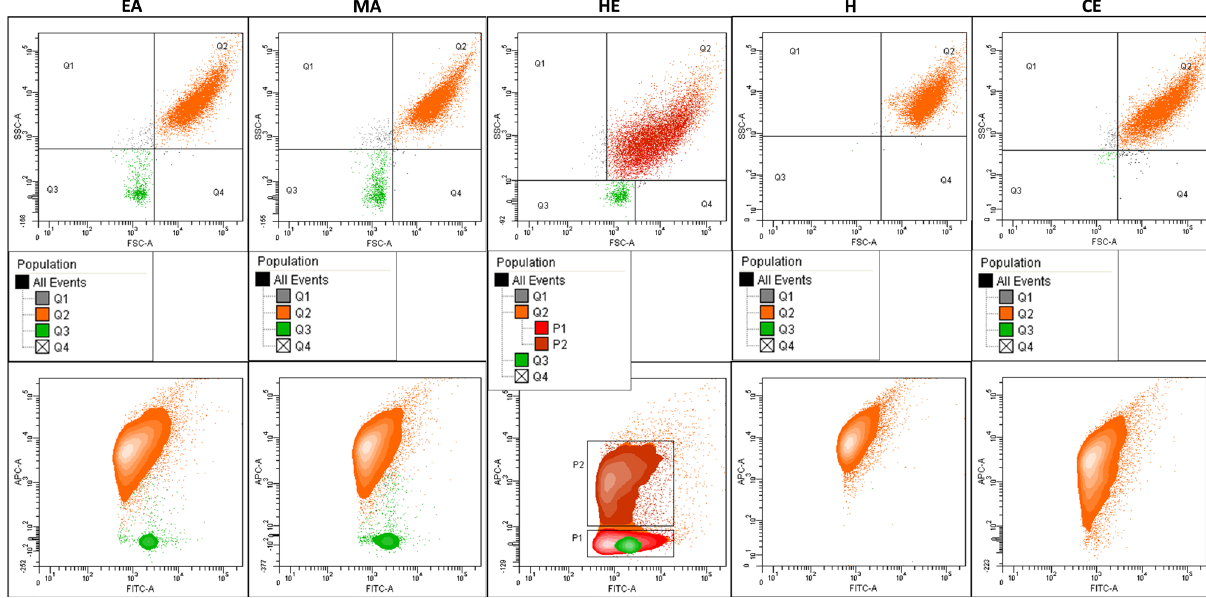
Figure 3: Diversity of MLV populations in terms of morphology and structure determined by flow cytometry. Bivariate contour plots in the upper row for each population FSC-A vs SSC-A, lower row – FITC-A vs APC-A. Diagrams indicate the gating strategy (structure of defined sub- populations). Sub-populations P1 and P2 (discriminated within the Q2 region using TO/DiD staining) indicate higher structural diversity of